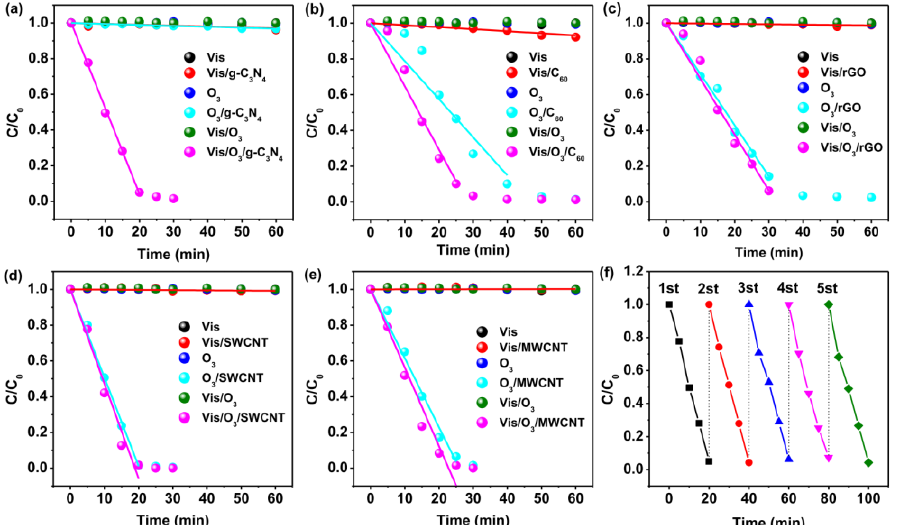
Figure 5. OA degradation upon ozonation and irradiation under various conditions in the presence of g-C 3 N 4 ( a ), C60 ( b ), rGO ( c ), SWCNT ( d ) and MWCNT ( e ); Repeated photocatalytic ozonation for OA degradation over 0.1 g/L g-C 3 N 4 ( f ) in five cycles. Reproduced with permission from Ref. [56]. Copyright 2016 Elsevier.